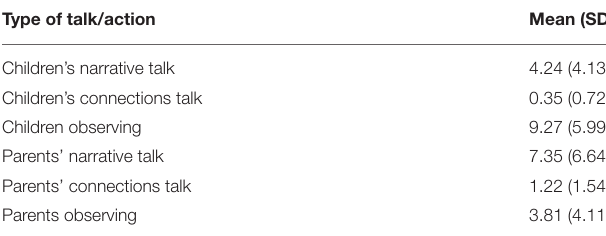
TABLE 3 | Parents’ and children’s talk and action at spin browser—Mean Number (SD) of 10-s segments coded ( n = 37; 23 families with girls, 14 families with